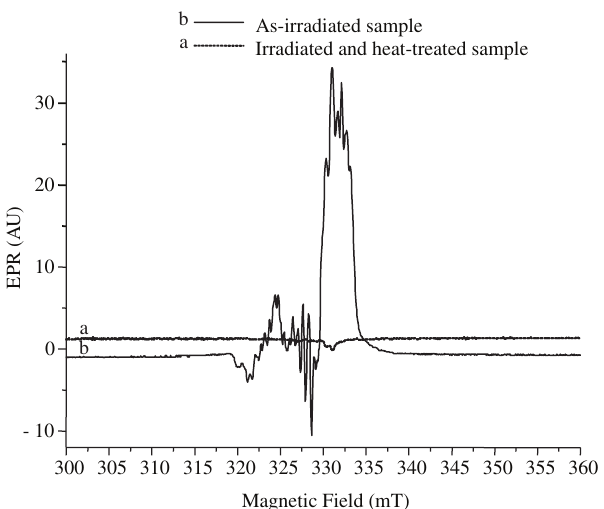
Figure 3. EPR spectrum from as-irradiated (200 kGy) and irradiated and heat-treated samples at 30 K.